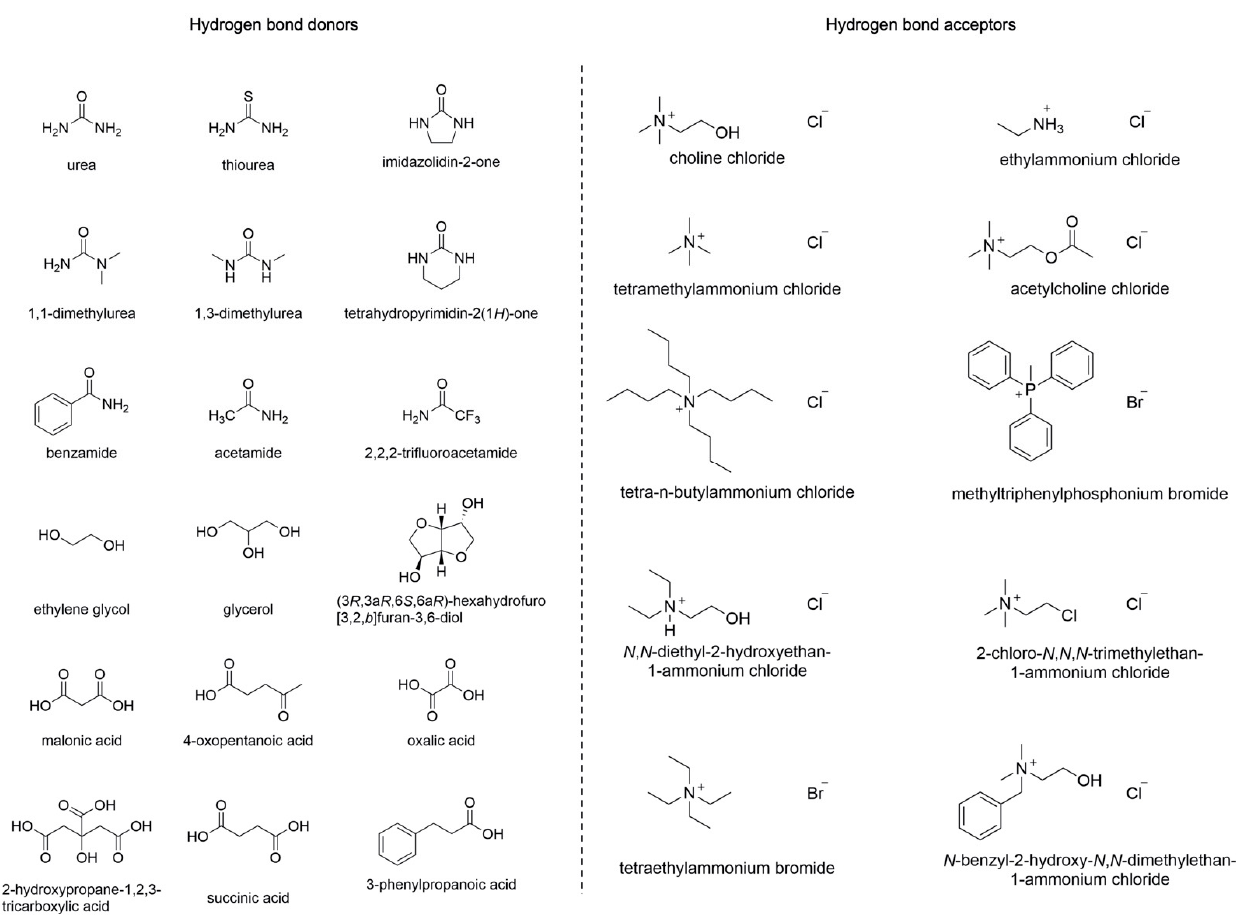
Figure 1. Typical HBDs and HBAs employed in DESs.